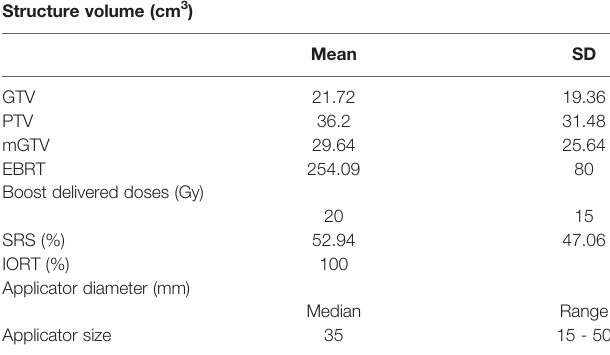
TABLE 1 | Planning baseline